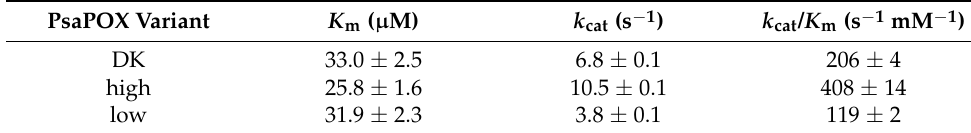
Table 1. Michaelis–Menten constants ( K m ), catalytic constants ( k cat ), and catalytic efficiencies ( k cat / K m ) for the PsaPOX variants (1 ng/mL) using 0.5 mM ABTS as a substrate in the presence of 100 µ M H 2 O 2 and 100 mM sodium acetate buffer, pH 3.5 at 40 ◦ C. Values are the average